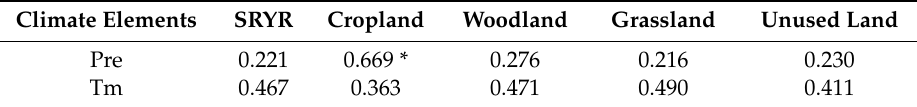
Table 2. Partial correlation coefficient.